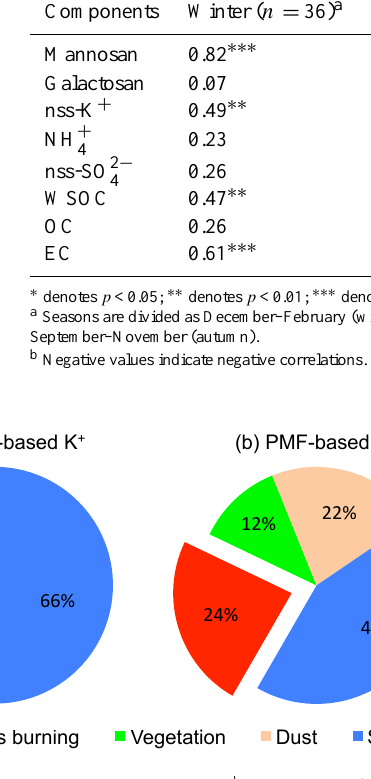
Figure 5. Components of water-soluble K + derived by (a) tracer- based method (Pio et al., 2008) and (b) PMF analysis. Details on PMF analysis can be found in the